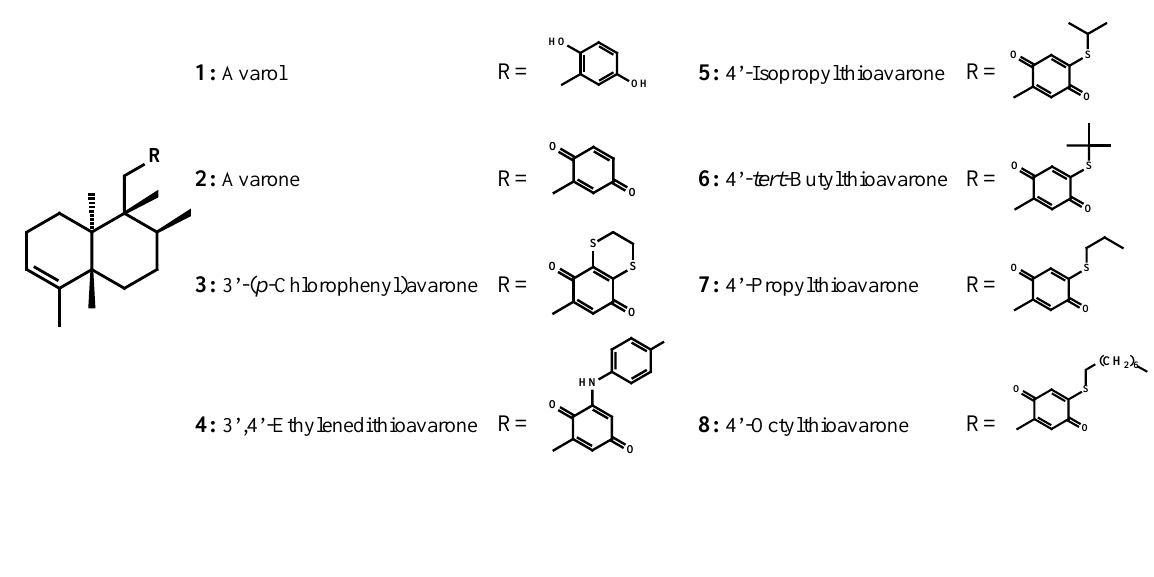
Figure 1 . Structures of assayed compounds 1-8